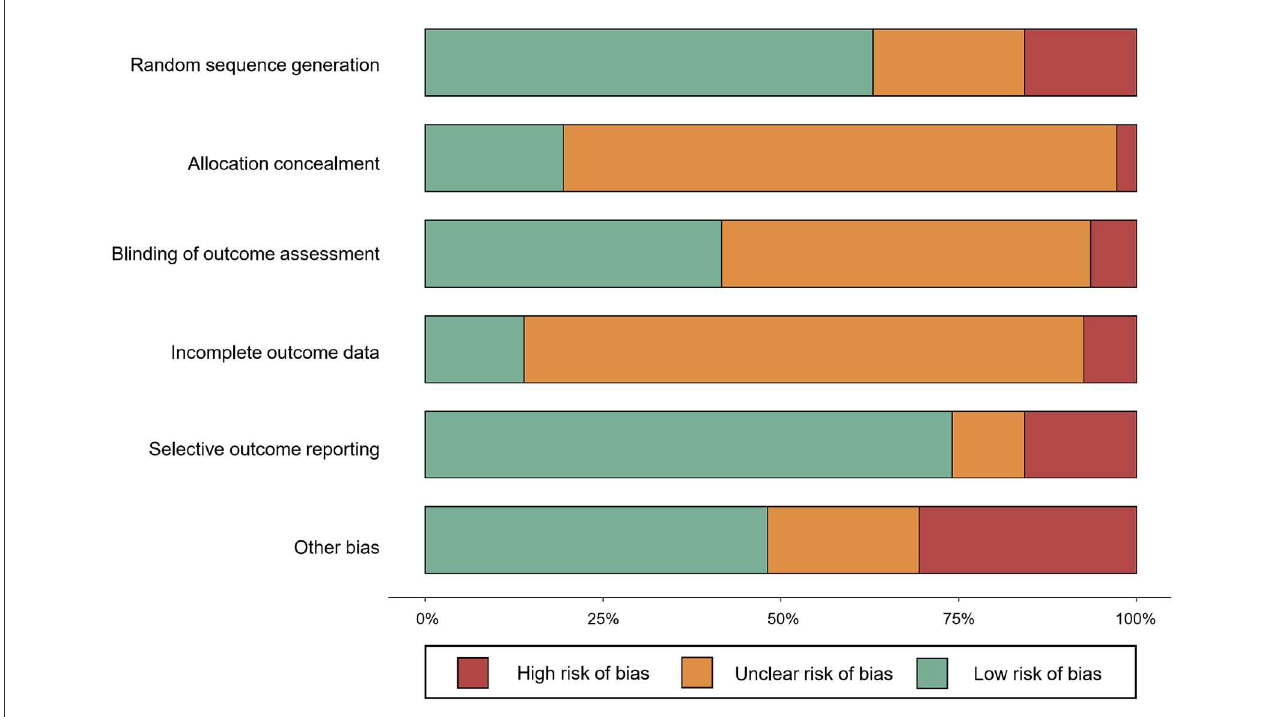
FIGURE1 Risk of bias assessment of included randomized controlled